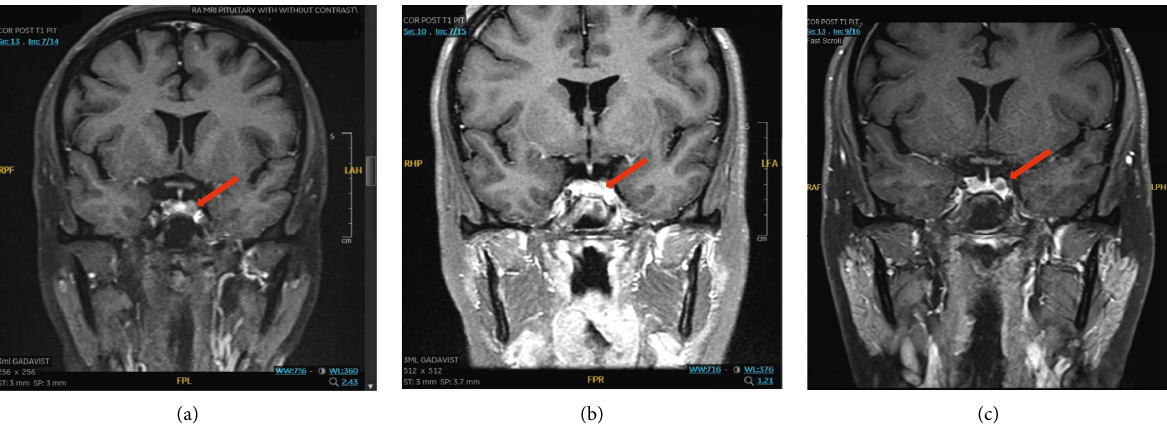
Figure 1: (a) Initial: MRI pituitary with and without contrast showing a coronal T1 postcontrast image immediately prior to our patient’s pituitary surgery. The red arrow points to a 3 × 3 × 5mm hypoenhancing focus representing a pituitary microadenoma. (b) Postsurgical: MRI pituitary with and without contrast showing a coronal T1 postcontrast image obtained three months after transsphenoidal pituitary surgery. The red arrow shows that a hypoenhancing focus is no longer seen and has been resected. (c) Postpartum: MRI pituitary with and without contrast showing a coronal T1 postcontrast image obtained four weeks postpartum. The red arrow points to a 3mm relatively hypoenhancing lesion representing a recurrent pituitary